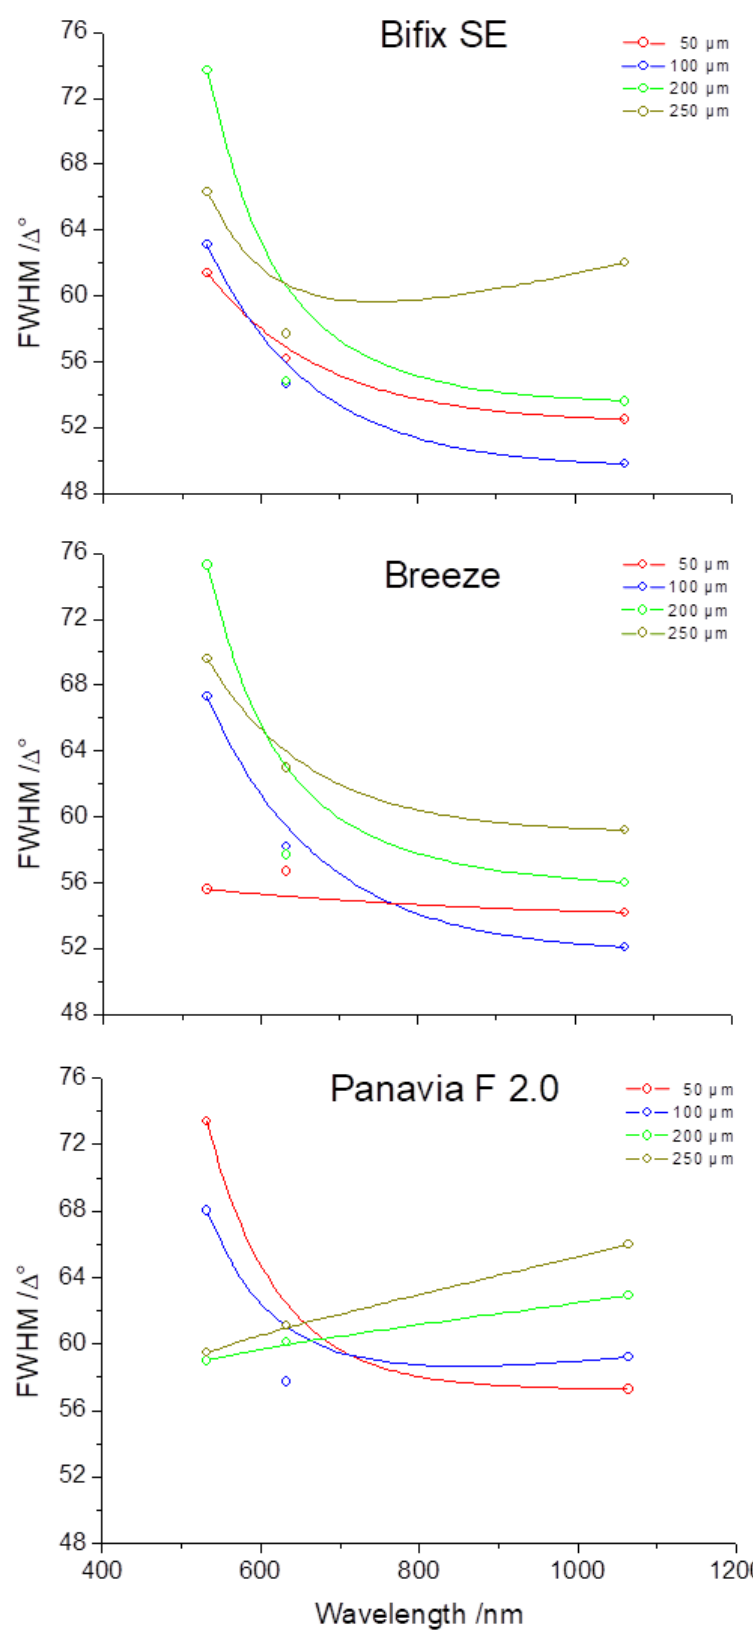
Figure 7. Schematic diagrams of the line widths (Full Width at Half Maximum (FWHM) of various cements as a function of the wavelength).